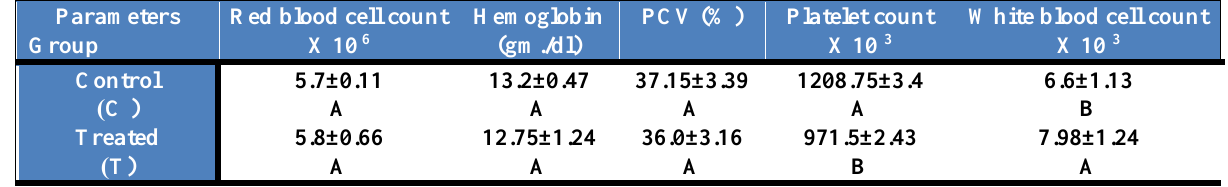
Table, 4: Effect of ethanolic extract from Metracaria chamomella on some hematological parameters in male